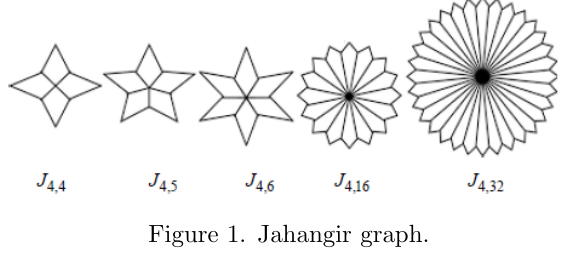
Figure 1. Jahangir